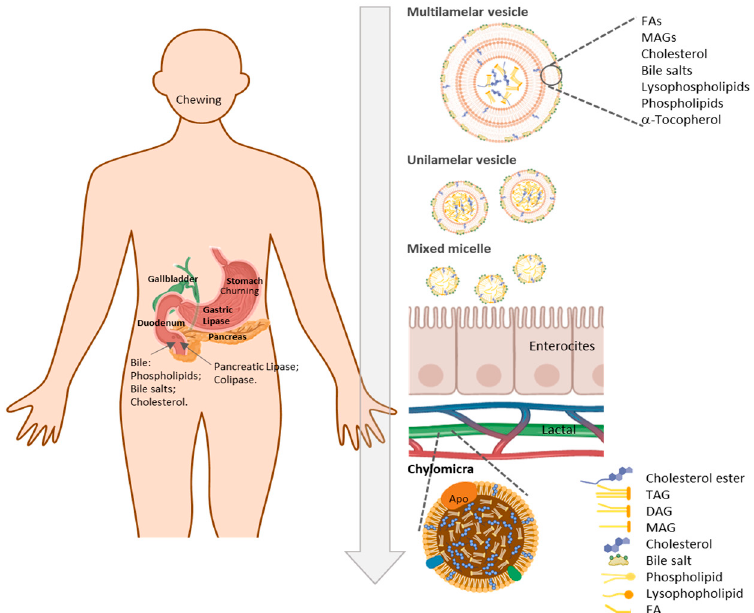
Figure 1. Illustrative steps of the digestion process of fats into the digestive track. Breakdown of multilamellar emulsion droplets to mixed micelles. The core of the emulsion vesicles contains triacylglycerols (TAGs), diacylglycerols (DAGs), and cholesteryl esters. On the surface are fatty acids, MAGs, phospholipids, lysolecithins, and cholesterol. Initially, gastric lipase is adsorbed to the surface, which is followed by pancreatic lipase and colipase. The addition of more bile salts to the multilamellar vesicle converts them into unilamellar vesicles. The further addition of bile salts leads to the formation of a mixed micelle. Mixed micelles carry lipids to the enterocyte surface and enter the enterocyte by nonionic diffusion, incorporation into the membrane (“collision”), or by carrier-mediated transport. The re-esterification of digested lipids by the enterocyte leads to the formation and secretion of chylomicrons to the lymphatic system.